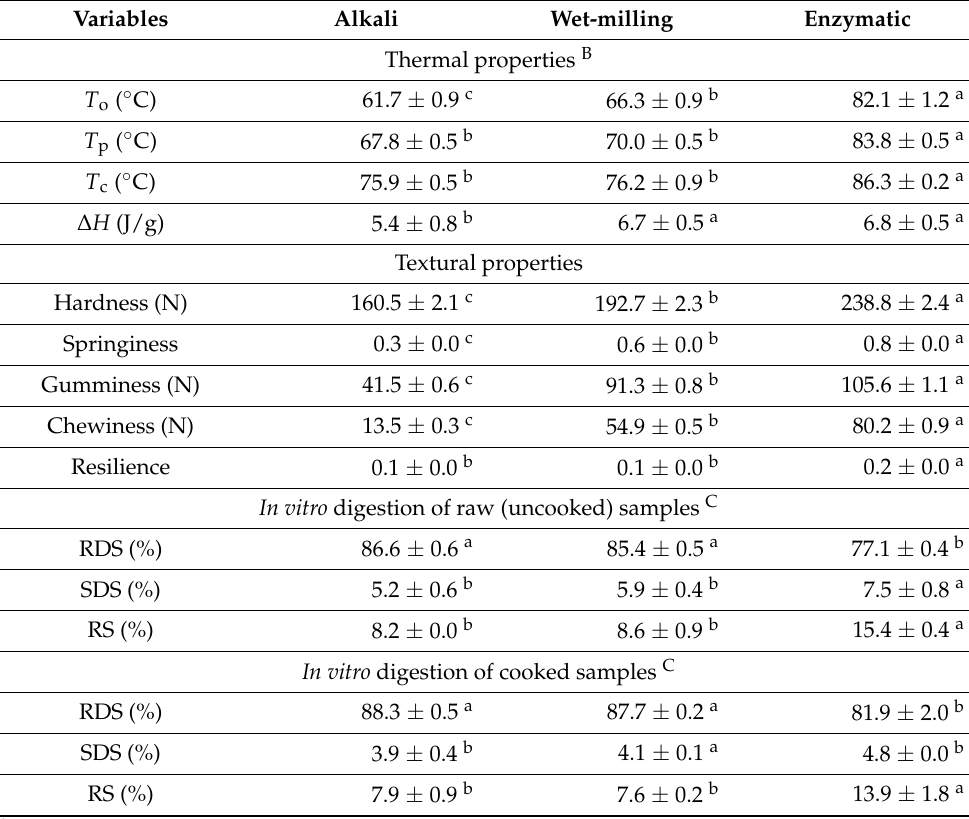
Table 3. Thermal, textural, and in vitro digestion properties of quinoa starch isolated by three different methods (alkali, wet-milling, and enzymatic) A . Variables